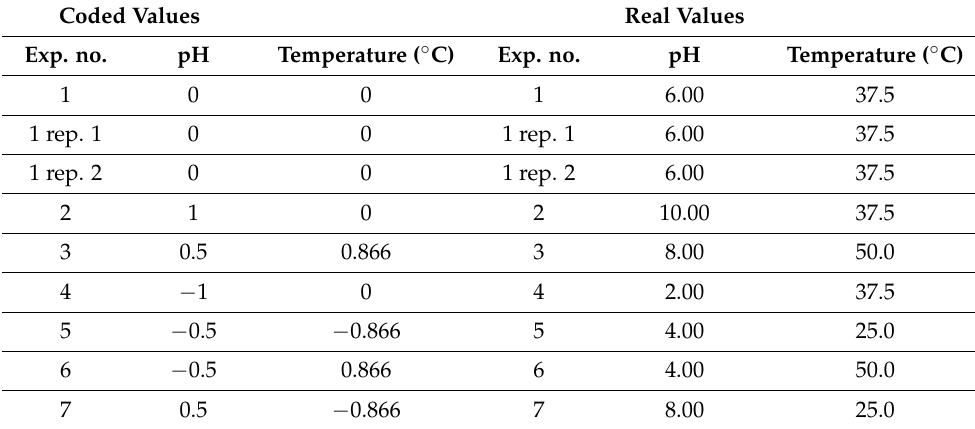
Table 1. Doehlert design for two